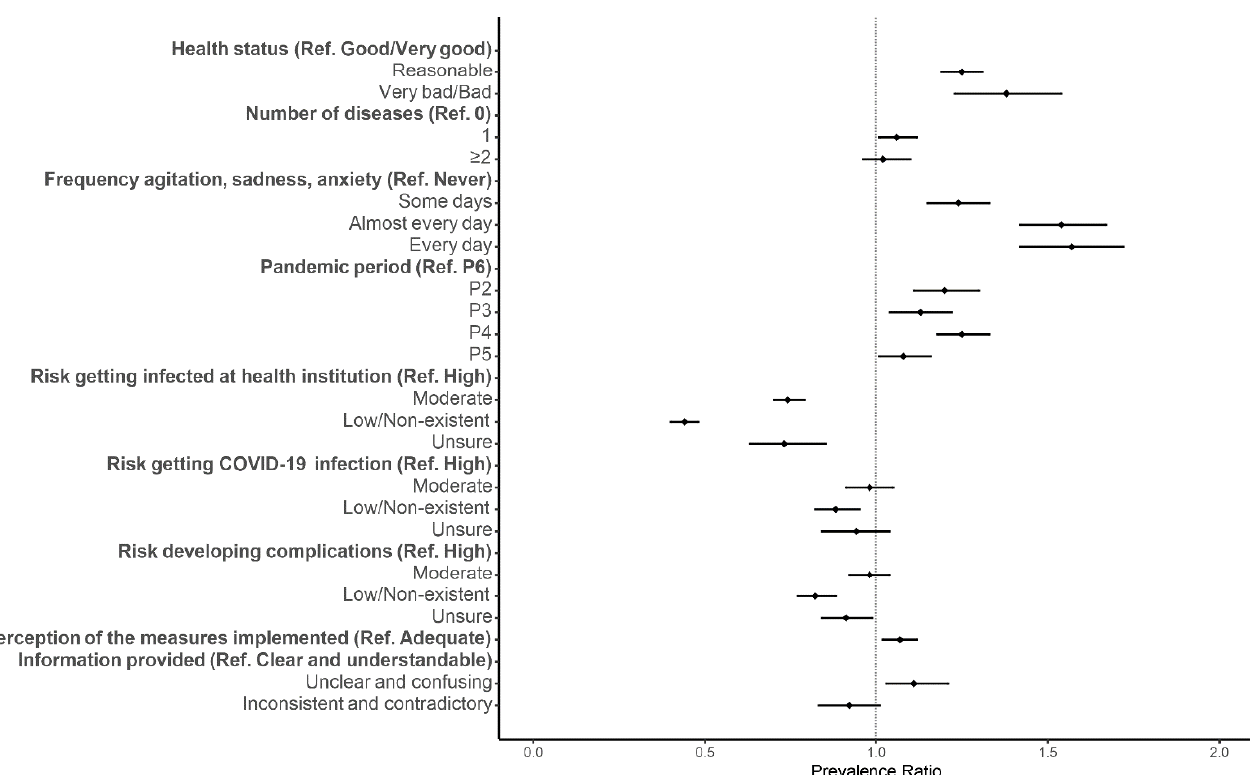
Figure 3. Forest plot of healthcare avoidance for the need for care and COVID-19-specific factors. Adjusted prevalence ratio (adjusted for gender, age group, region, education, health perception and period of the questionnaire) and the respective 95% confidence intervals are denoted by black dots and black lines, respectively.